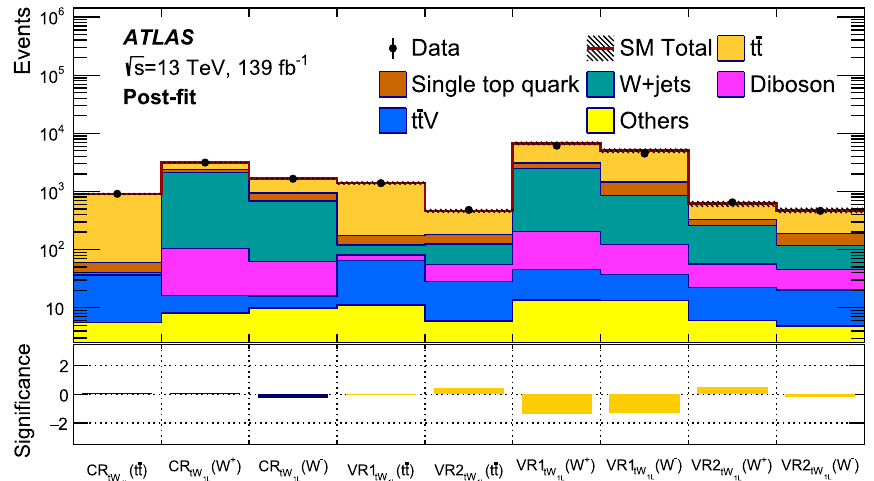
Fig. 3 Comparison of the predicted backgrounds with the observed numbersofeventsintheCRsandVRsassociatedwiththetW 1L channel. Thenormalisationofthebackgrounds isobtainedfromthebackground- only fit to the CRs. The ‘Others’ category includes contributions from Z +jets and tW Z production, and rare processes such as triboson, t ¯ tt ¯ t ,